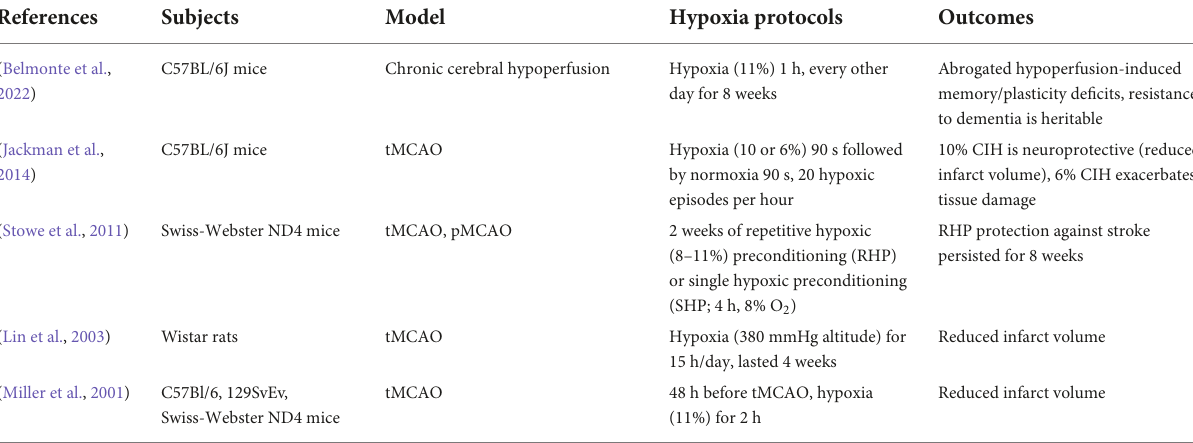
TABLE 3 Beneficial effects of intermittent hypoxia preconditioning in ischemic stroke.